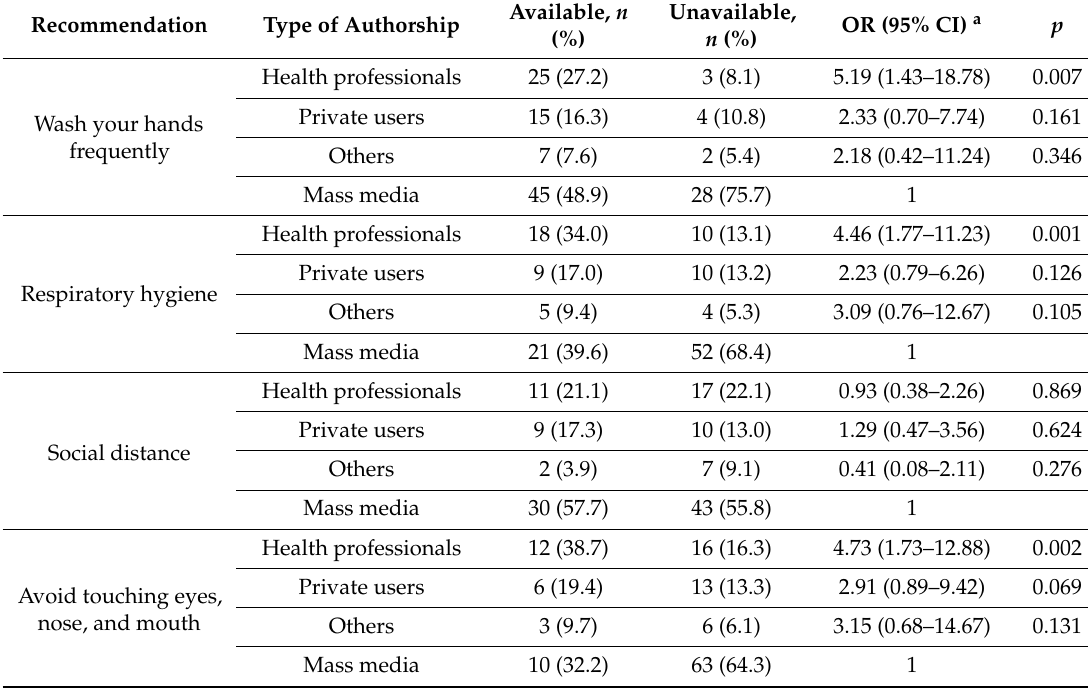
Table 2. Recommendations to prevent transmission of coronavirus disease 2019 (COVID-19) according to the authorship of the video.